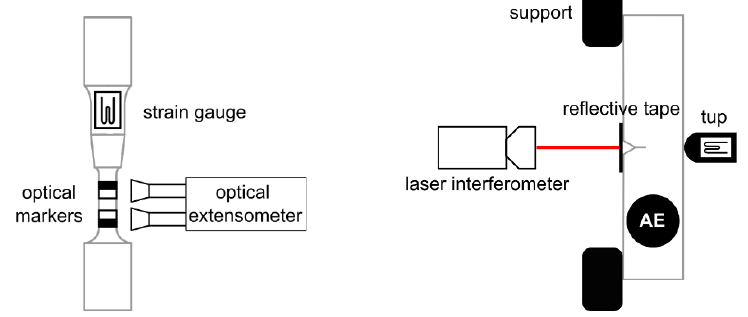
Fig. 2. Setup for dynamic tensile tests (left) and Charpy impact tests